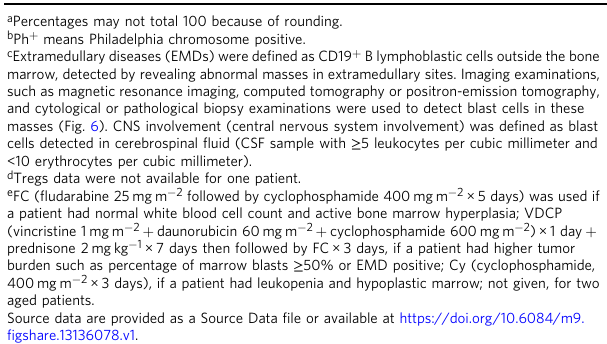
burden such as percentage of marrow blasts ≥ 50% or EMD positive; Cy (cyclophosphamide, 400mgm − 2 ×3 days), if a patient had leukopenia and hypoplastic marrow; not given, for two aged patients. Source data are provided as a Source Data fi le or available at https://doi.org/10.6084/m9. fi